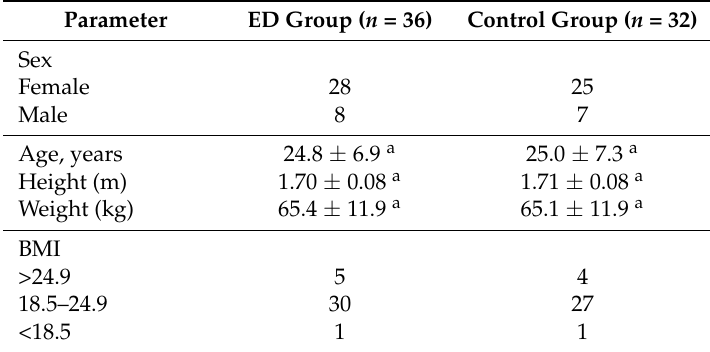
Table 2. Baseline characteristics of the study subjects.